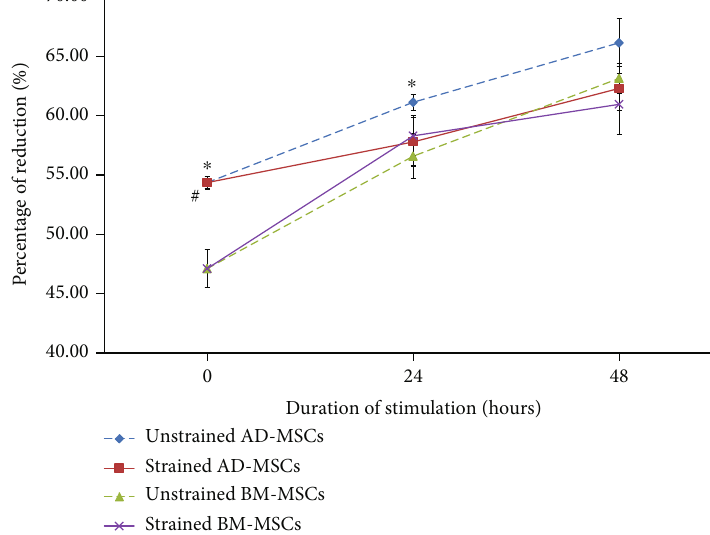
Figure 5: Comparison between the cellular proliferation of AD-MSCs and BM-MSCs with or without mechanical stimulation at di ff erent durations of cell culture. The cell proliferation rate higher in AD-MSCs as compared to BM-MSCs when left to grow on silicone chambers. This did not appear to be the case when cells were subjected to cyclical stretching at 8% and 1Hz. There was no signi fi cant di ff erence for both these types of cells and when compared to unstrained cells when mechanical stimulation was applied. Signi fi cance ( p < 0 : 05 ) was indicated with an asterisk ( ∗ ) which compared unstrained AD-MSCs and unstrained BM-MSCs in di ff erent duration, while signi fi cance ( p < 0 : 05 ) was indicated with a hash (#) which comparison between strained AD-MSCs and strained BM-MSCs in di ff erent duration. N = 4 , n = 3 . Errorbar = ±SD